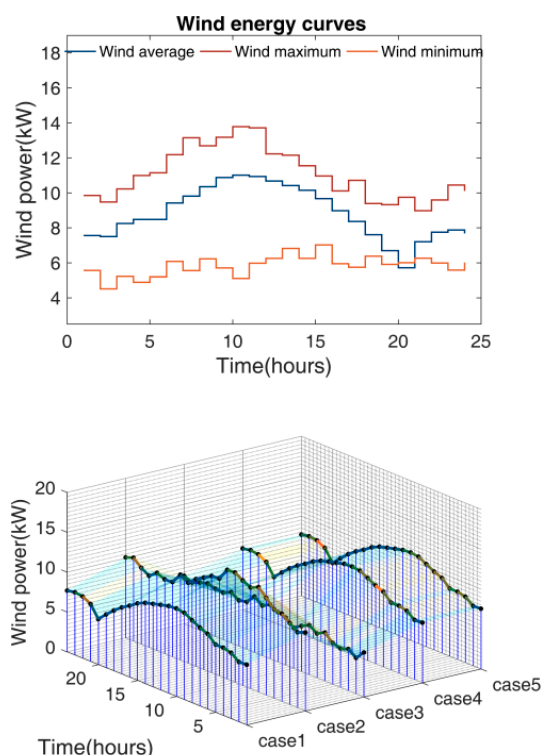
Figure 10. Energy availability from wind .